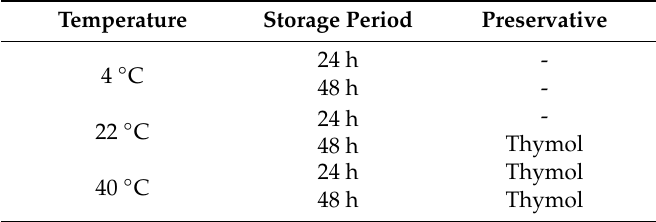
Table 5. Guidelines for urine sample storage for metabolomics